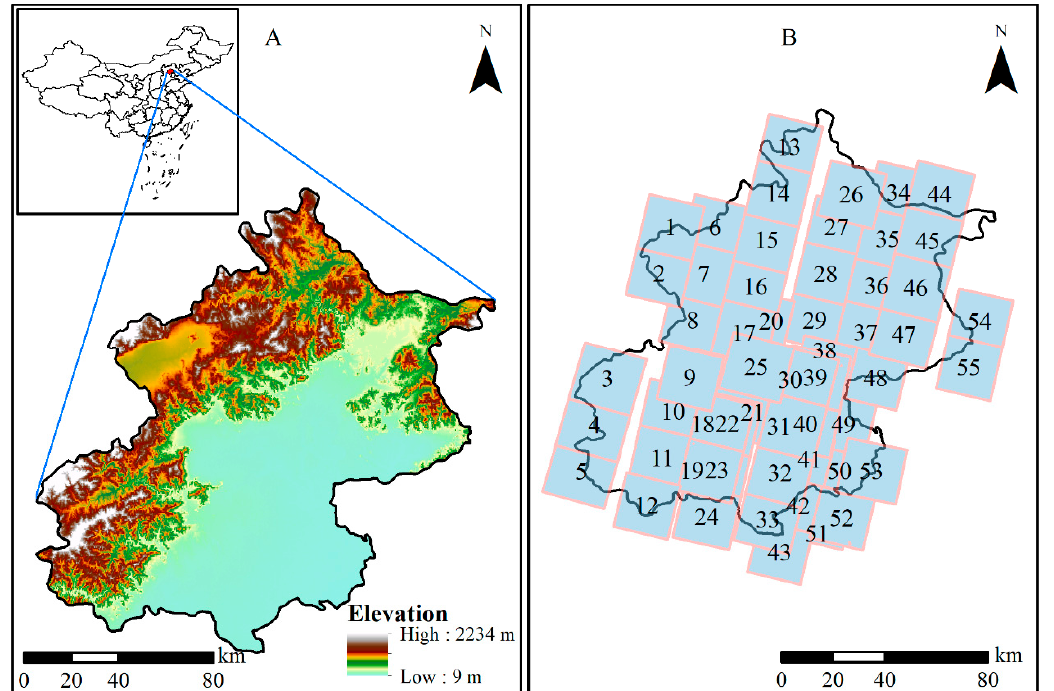
Figure 1. Location of Beijing ( A ) and the coverage of GF-2 images ( B ).